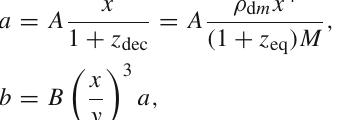
Fig. 1 we show the merger rate estimated by using the ini- tial distribution (7) and the simplified distribution (8), which indicates that the difference between the two cases is insignif- icantcomparedtotheuncertaintyofthemergerrateestimated by the LIGO-Virgo Collaboration.